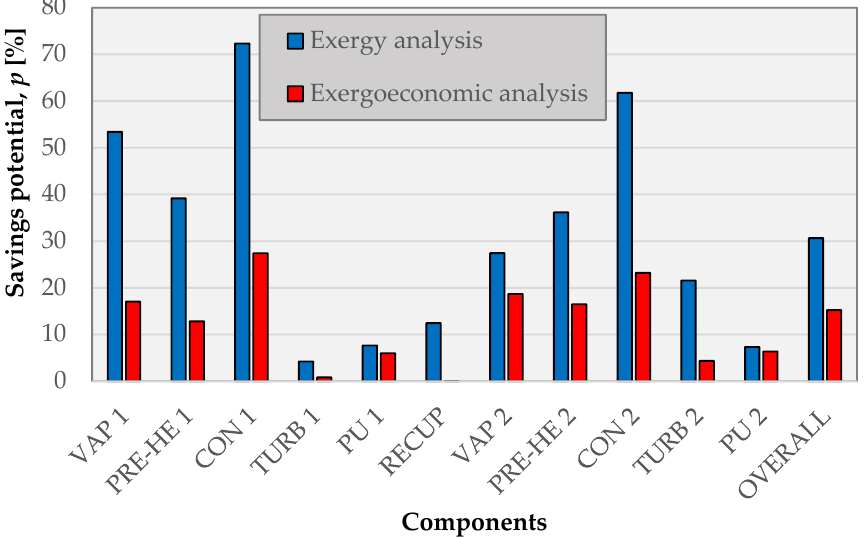
Figure 10. Change in saving potential for the system and its components with the AdvEx-based analysis.